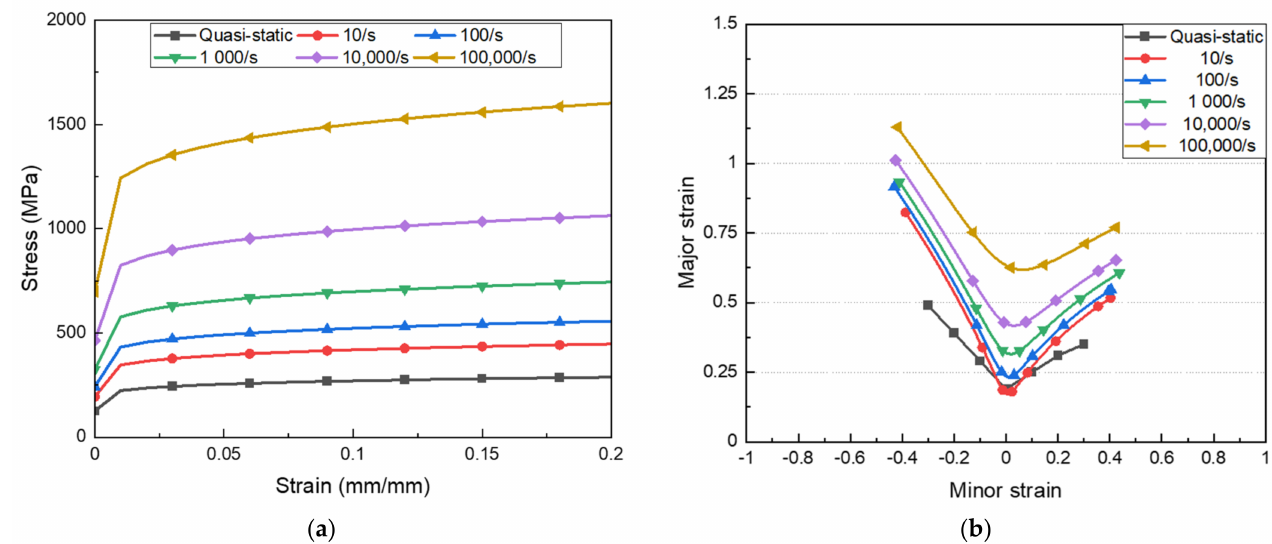
Figure 3. Dynamic properties of Al 6014-T4: ( a ) true stress–strain curve, ( b ) forming limit diagram